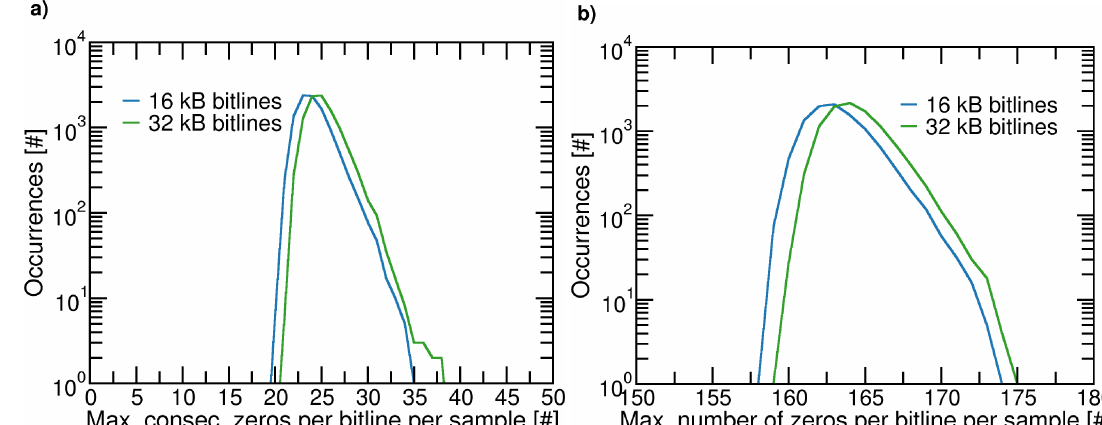
Figure 6. ( a ) Maximum consecutive number of zeros in a bitline per generated sample as a function of the bitlines’ dimension; ( b ) Maximum number of zeros in a bitline per generated sample as a function of the bitlines’ dimension. In these simulations we consider 256